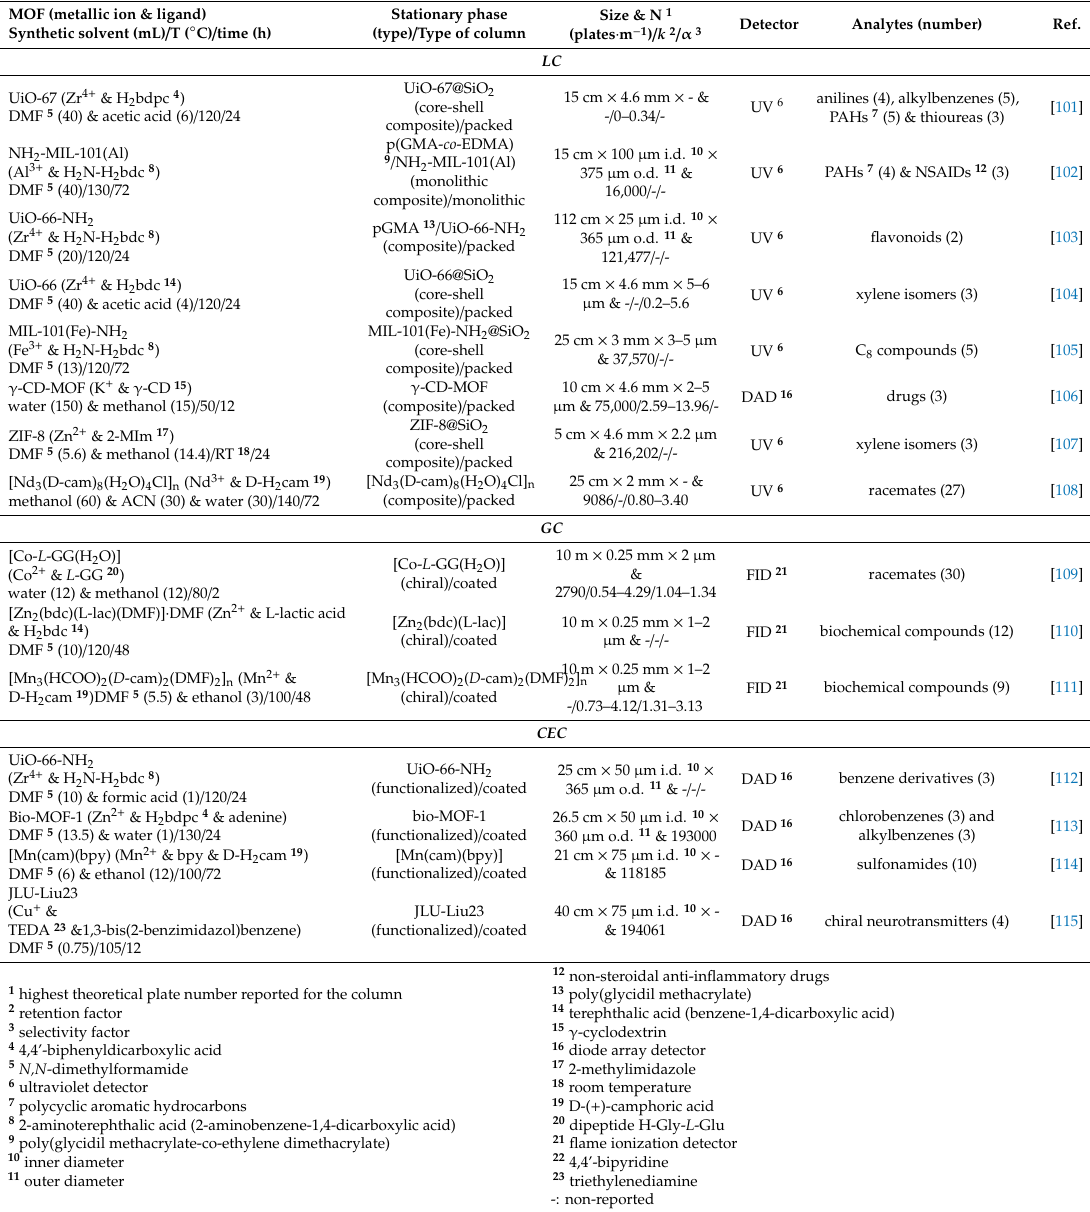
Table 3. Representative examples of chromatographic stationary or pseudo-stationary phases incorporating MOFs as novel materials in the period 2017–2019.